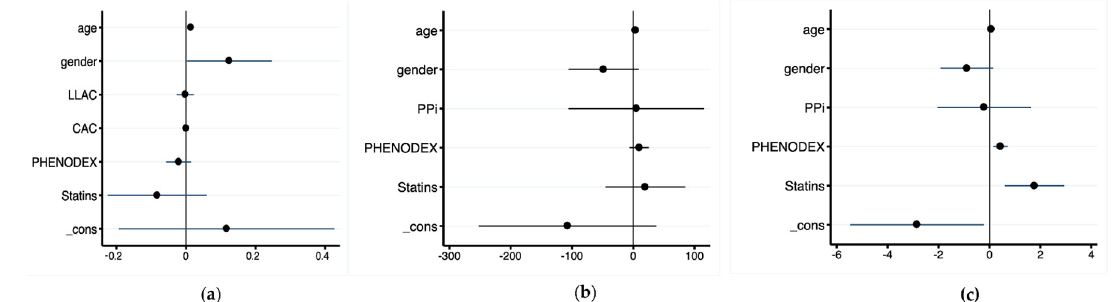
Figure 2. Coefficient plots from multivariable stepwise regression models with PPi ( a ), CAC ( b ) and LLAC ( c ) as dependent variables.